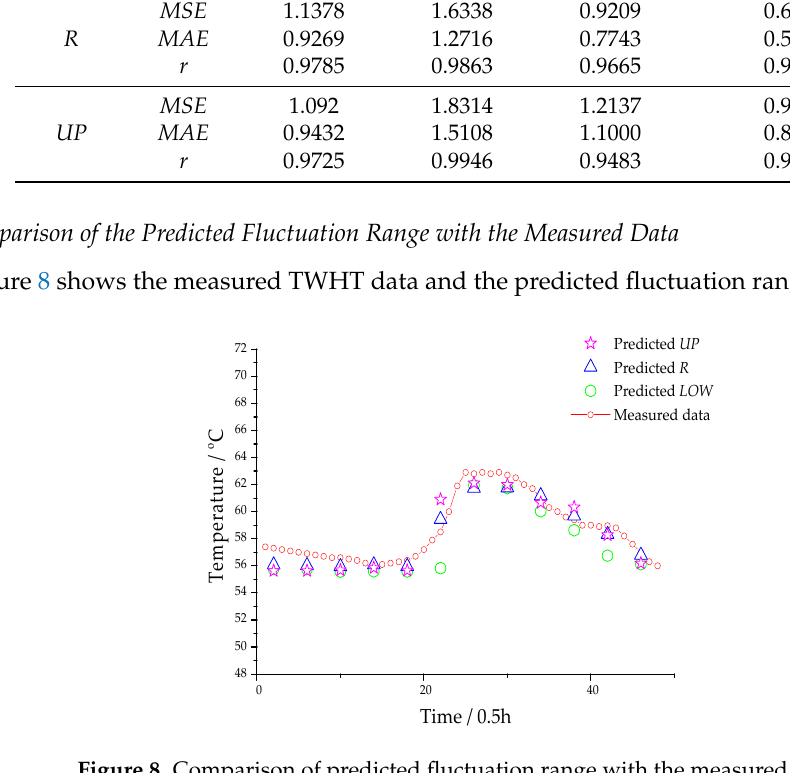
Table 4. Comparison of the measured data and the predicted data.